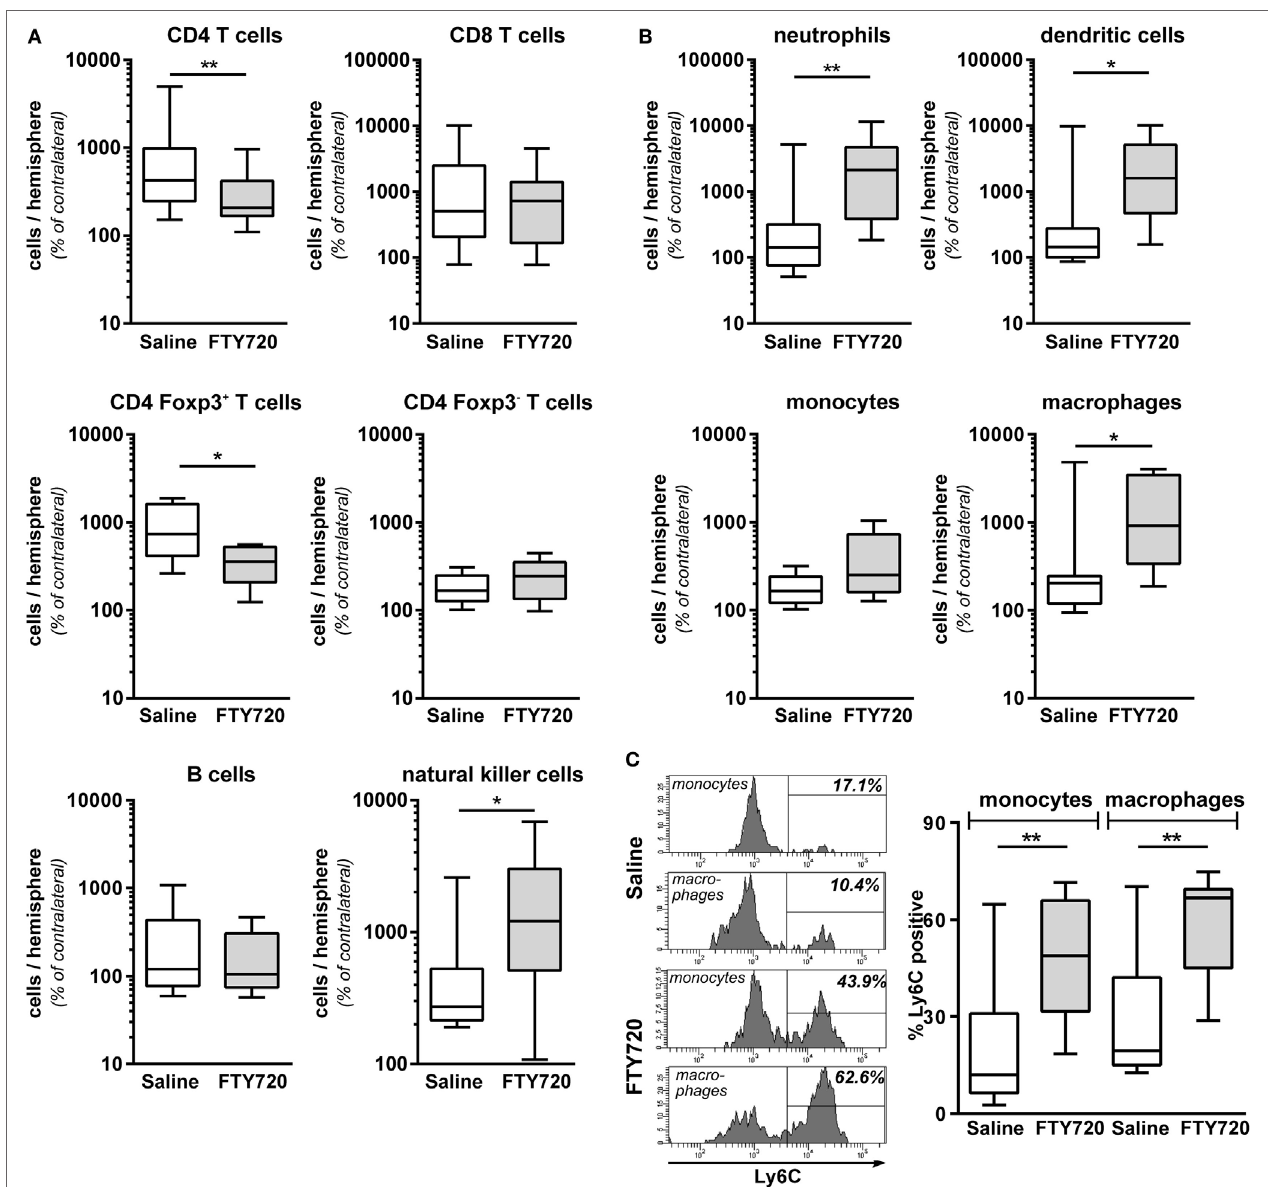
FigUre 5 | Peripheral T cell depletion by FT720 reduces the amount of T cells but increases innate immune cells in the hypoxic-ischemic brain. Multichannel flow cytometry was performed on immune cells isolated from ipsilateral and contralateral hemispheres obtained from P16 mice that were exposed to HI followed by a single intraperitoneal injection of 1 mg/kg FTY720 or 0.9% NaCl (saline) on P9. Different immune cell subsets were identified according to the gating strategy provided in Figure S1 in Supplementary Material. Briefly, viable peripheral leukocytes were identified as CD45 high FVD (fixable viability dye) − cells and further subdivided into B lymphocytes (CD19 + ), natural killer cells (NK1.1 + ), CD4 T cells (CD19 − , NK1.1 − , CD3 + , CD4 + ), CD8 T cells (CD19 − , NK1.1 − , CD3 + , CD8 + ), and regulatory T cells (CD3 + , CD4 + , Foxp3 + ) T cells (a) . For analysis of myeloid subsets viable leukocytes were gated for lymphocyte-depleted cells (CD3 − , NK1.1 − , B220 − ) and further subdivided into monocytes (CD115 + , Ly6G − ) and neutrophils (CD115 − , Ly6G + ). Remaining cells were gated by CD11b and CD11c to distinguish dendritic cells (Ly6G − , CD115 − , CD11c high ) and macrophages (Ly6G − , CD115 − , CD11c − , CD11b + ) (B) . Absolute lymphocyte (a) and myeloid (B) cell counts were quantified in contralateral and ipsilateral hemispheres. Numbers in ipsilateral hemispheres were related to contralateral hemispheres of the same animals to correct for inter-experimental variations due to isolation procedures. For monocytes and macrophages, the proportion of inflammatory cells was quantified based on their Ly6C expression (c) . FTY720 treatment significantly reduces the amount of infiltrated CD4 T cells and particularly regulatory T cells, which was accompanied by an increased infiltration of innate especially inflammatory myeloid cell types. n = 8–22 samples/group (two hemispheres pooled per sample), * p < 0.05, ** p < 0.01, unpaired t -test for Foxp3 + and Foxp3 − CD4 T cells in (a) and monocytes in (B) , remaining: Mann–Whitney